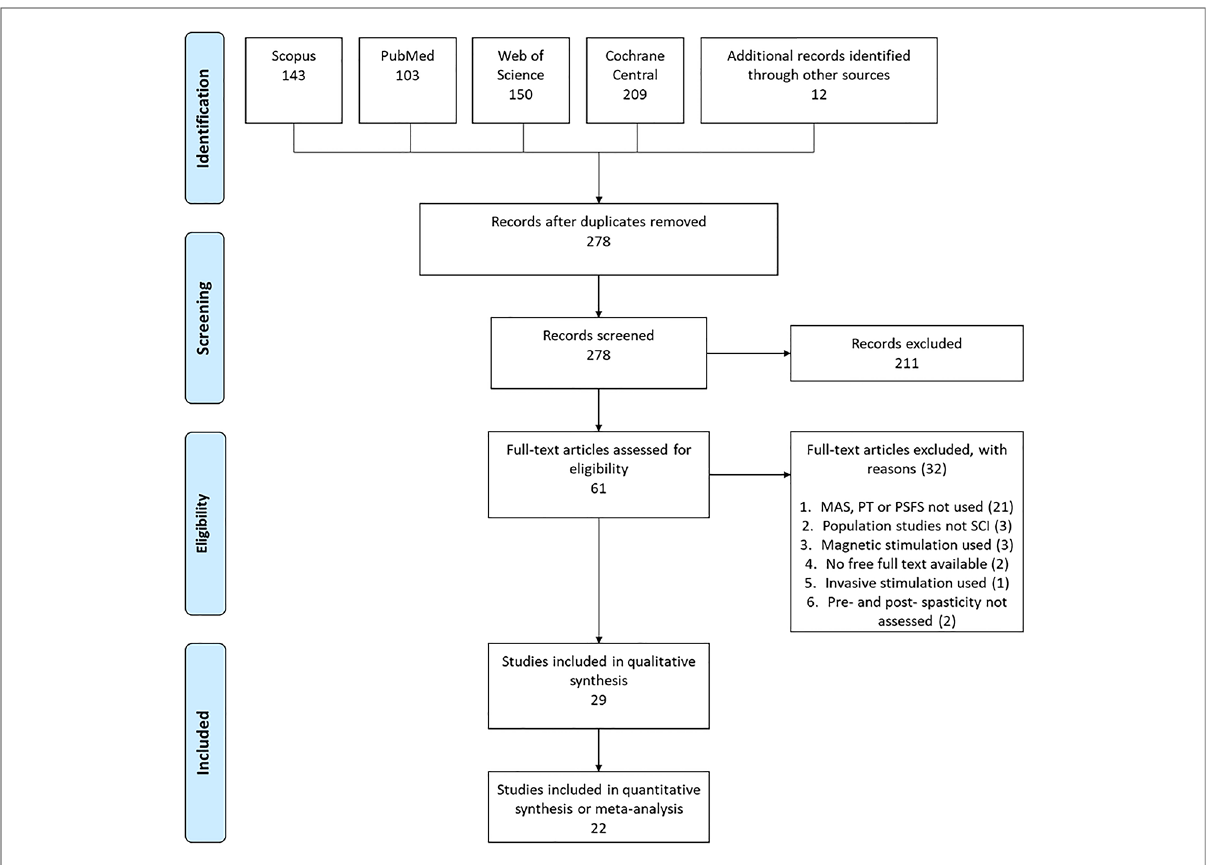
FIGURE 1 PRISMA fl ow diagram of included